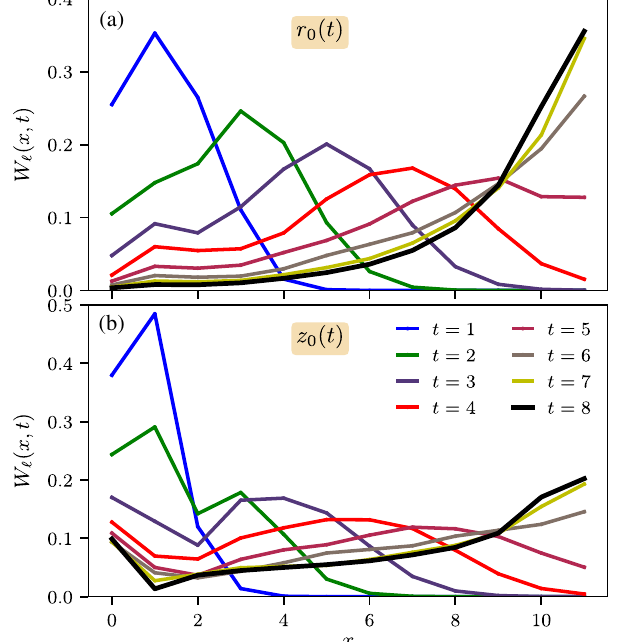
FIG. 7. l -weight profile W l ð x; t Þ Eq. (58) of spreading oper- FIG. 6. l -weight profile W l ð x; t Þ Eq. (58) of spreading oper- ators σ x 0 ð t Þ and σ y 0 ð t Þ in a thermalizing Hamiltonian model that ators z 0 ð t Þ and r 0 ð t Þ in a Floquet model that conserves S tot z conserves energy Eq. (59), plotted for a system of length L ¼ 14 . Eq. (57), plotted for a system of length L ¼ 12 . The expected σ x diffusive “ lump ” in the right-weight profile of the spreading 0 has nontrivial overlap with the local conserved energy density operators, which is visible in the enhanced weight of W l ð x; t Þ for conserved charge is manifested in the enhanced weight of x ¼ 0 , 1 even at late times (a). By contrast, σ y W x; t Þ at x ¼ 0 for z t Þ , even at late times (b). No such l ð 0 ð orthogonal to the conserved charges and its late-time l -weight enhancement is observed for r 0 ð t Þ which evolves orthogonal to profile does not show a “ lump ” at x ¼ 0 , 1. While the late-time the conserved charges (a). Notice also that the late-time decay of W x; t Þ away from x ¼ L is much slower for z t Þ as compared decay of W l ð x; t Þ away from x ¼ L is again faster for σ y 0 ð t Þ as l ð 0 ð to r 0 ð t Þ , consistent with the presence of power-law diffusive tails compared to σ x 0 ð t Þ , the difference is not as pronounced as the in the right-weight profile of the former but not the latter. difference between z 0 ð t Þ and r 0 ð t Þ in the U ð 1 Þ Floquet case. This is because σ y 0 ð t Þ can develop overlap with the slow conserved charges, unlike r 0 ð t Þ which is constrained to remain strictly orthogonal to the charges during its entire